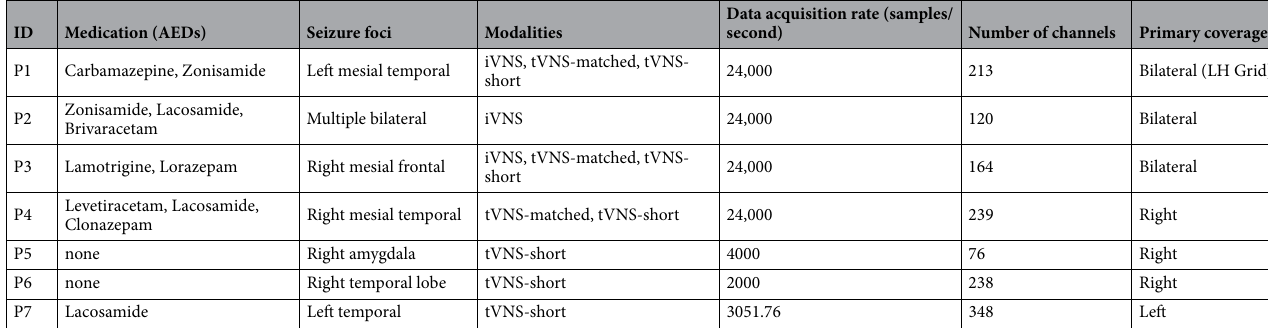
Table 2. Participant info and electrophysiological recording